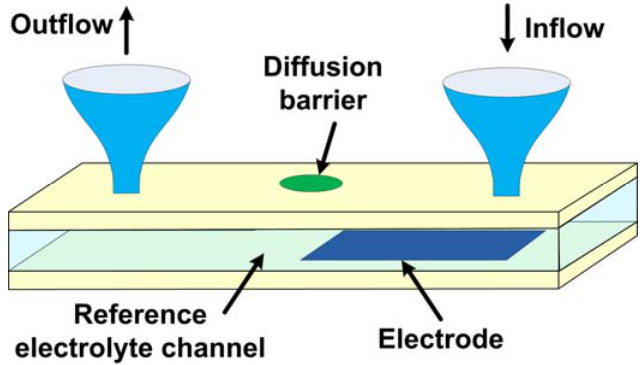
Figure 5. Illustration of a flow-through